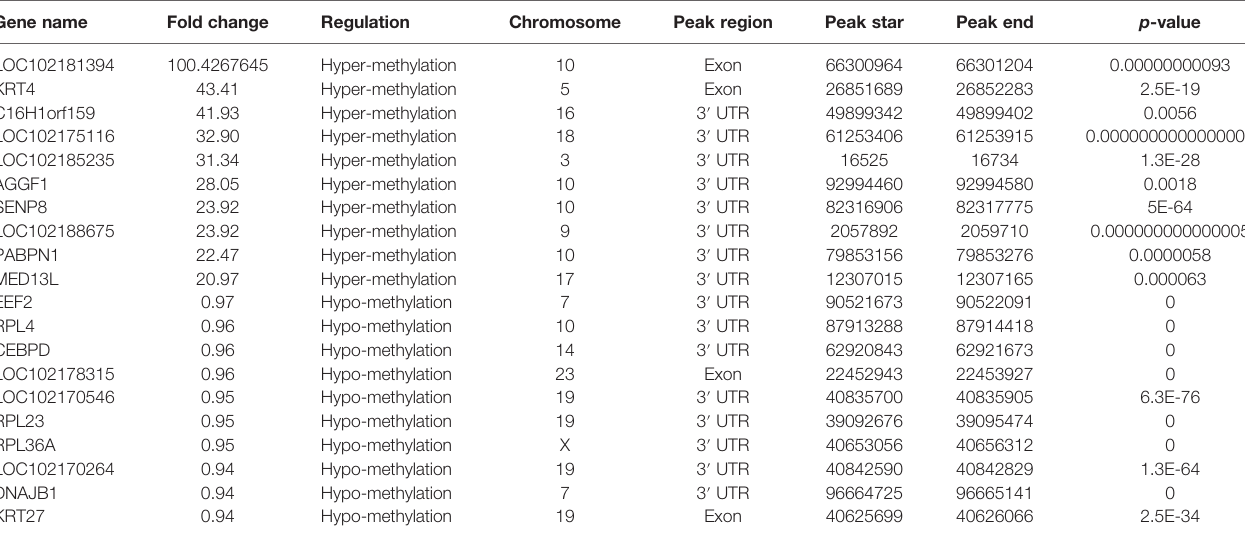
TABLE 3 | The top 20 differently expressed m6A